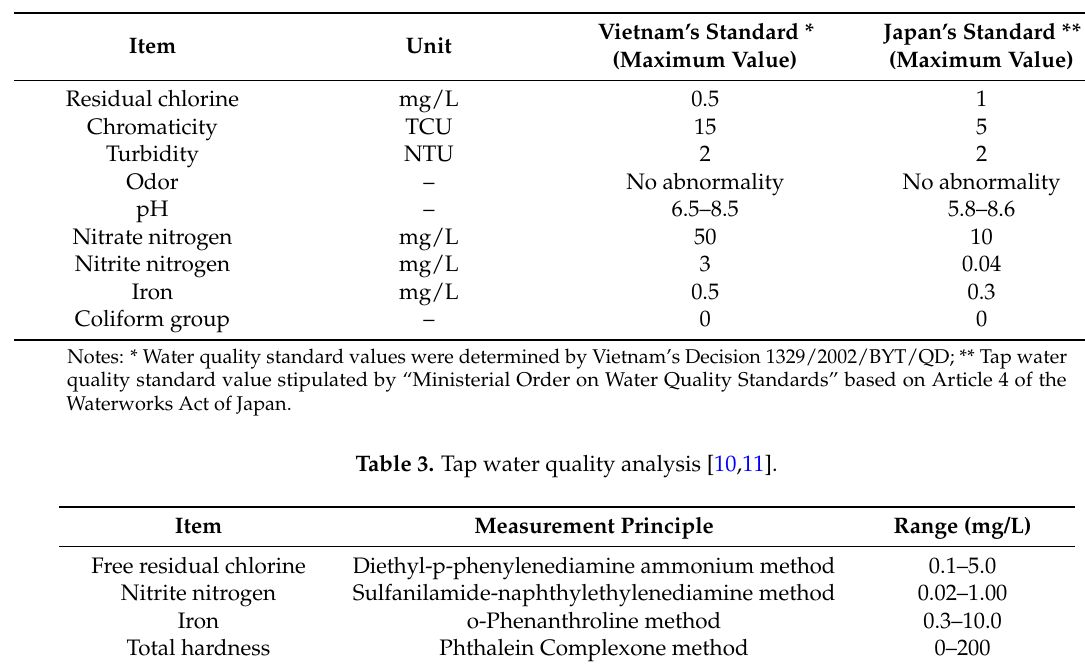
Table 2. Comparison of Vietnam and Japan’s water supply water quality standard values.